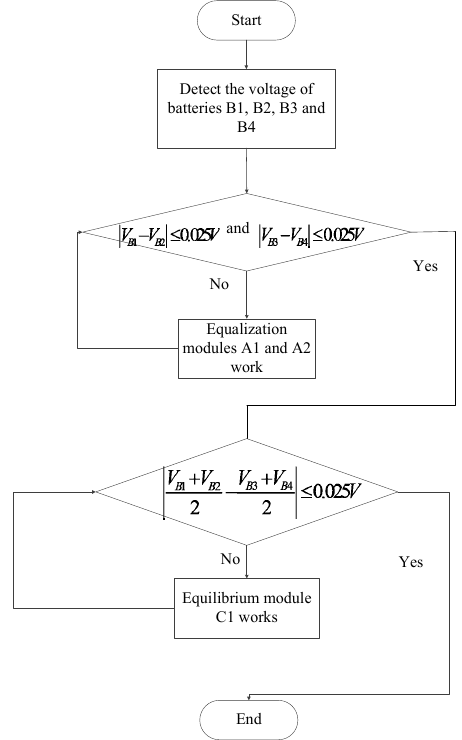
Figure 13. Flowchart for the battery pack equalization strategy in [26].